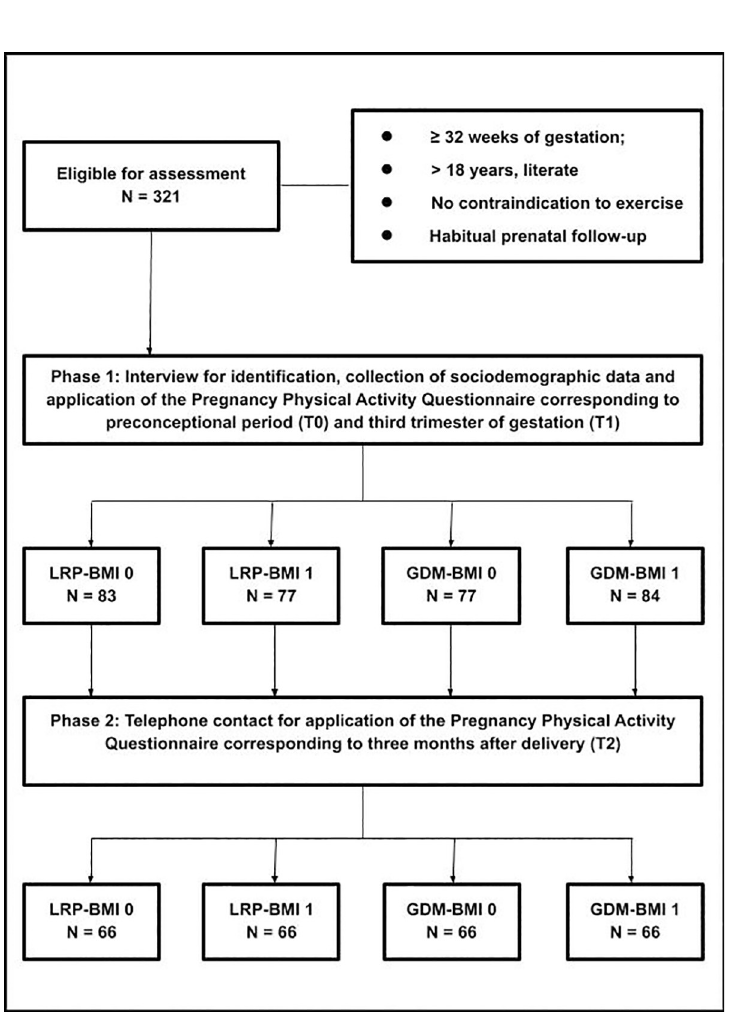
Fig 1. Flowchart of the study casuistry. LRP = low-risk pregnancy; GDM = gestational diabetes mellitus; BMI 0 = normal weight body mass index; BMI 1 =